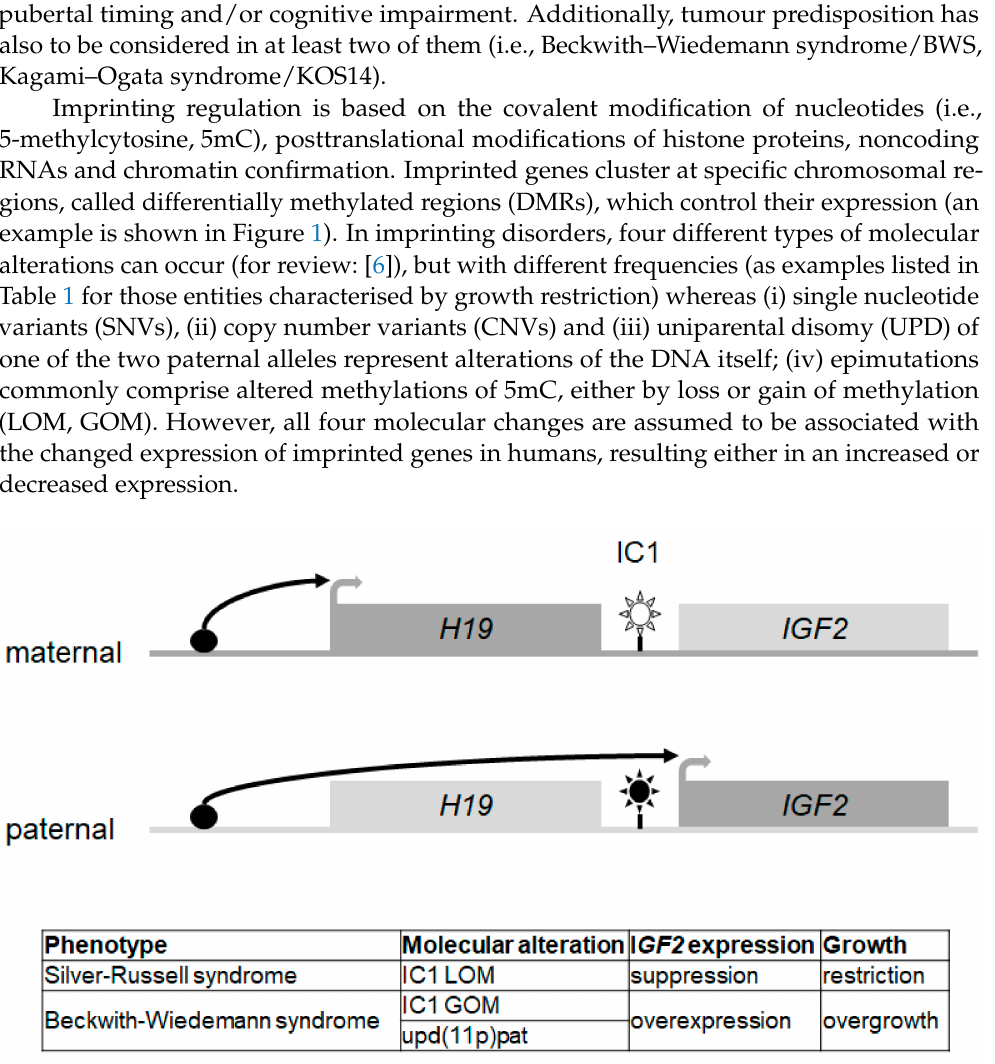
Figure 1. The imprinting centre 1 (IC1) region in 11p15 as an example for imprinting regulation and its disturbances. (LOM, loss of methylation; GOM, gain of